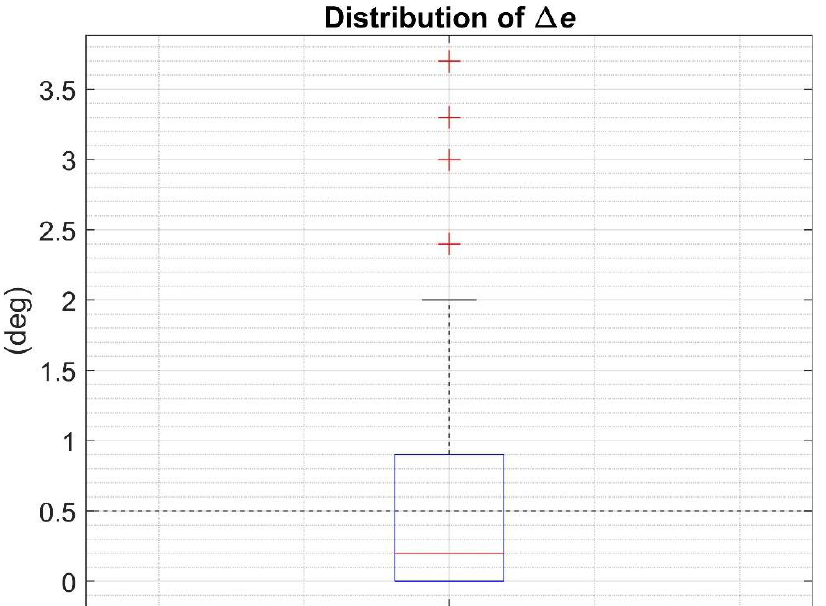
Figure 4. Boxplot of the distribution of the 90 residuals ( ∆ e ). Outliers are also reported(red cross). The limit of 0.5 deg chosen to consider the suboptimal errors equivalent to the optimal error is also highlighted.